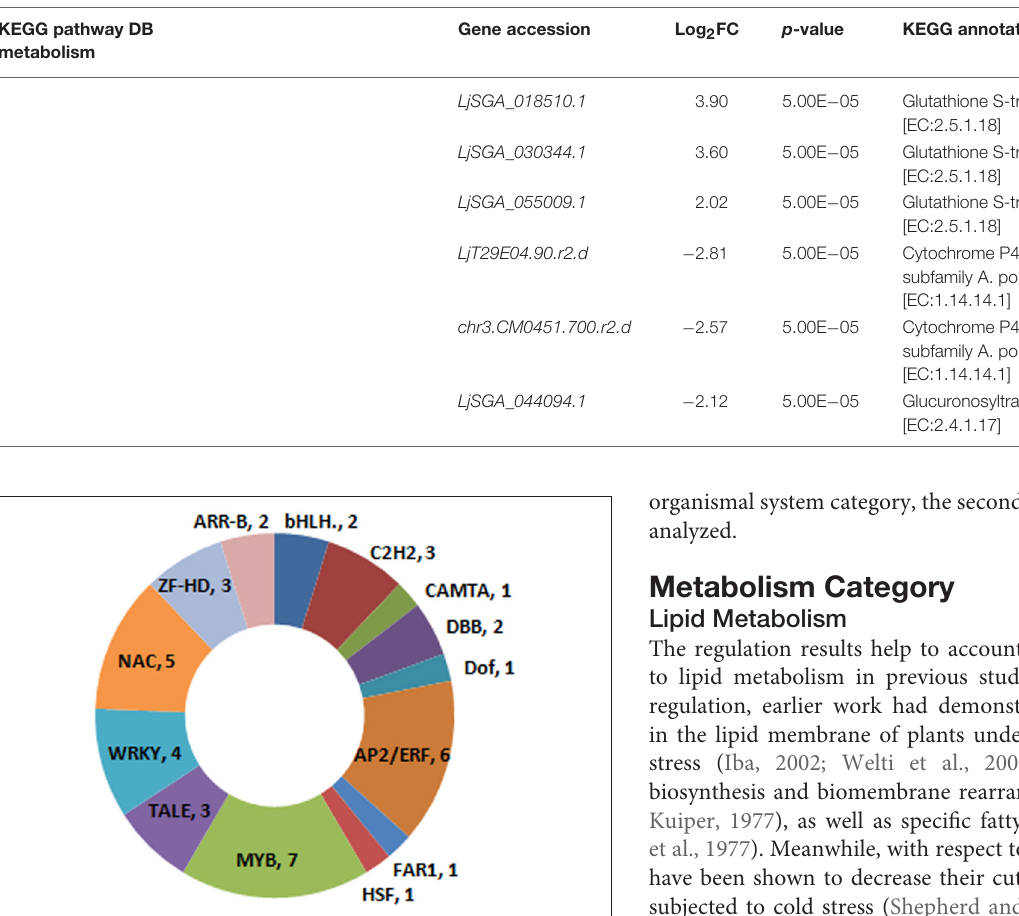
( Figure 6E ). Finally, RD29A ( chr5.CM0148.540.r2.m ) and COR47 ( chr1.CM0113.680.r2.d ), two DREB1/CBF TF